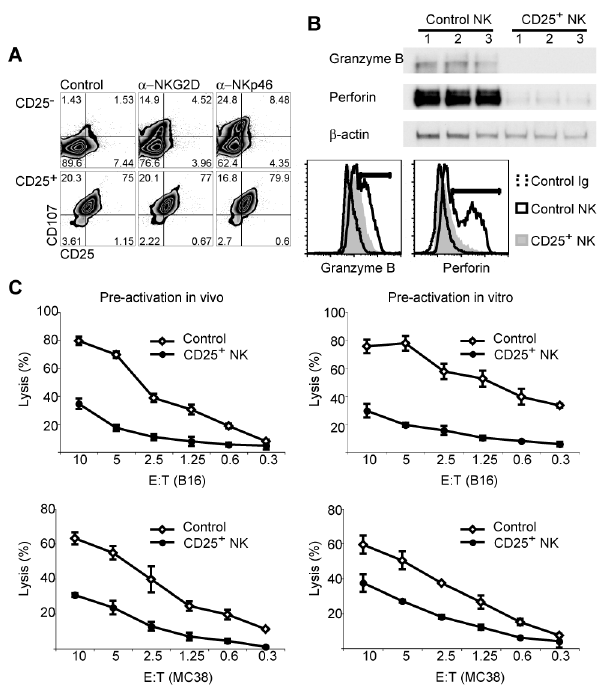
Figure 2. Post-activation NK cells have reduced cytolytic activity. A. Post-activation CD25 + and non-activated CD25 2 NK cells were isolated from spleens of B16-bearing mice and were incubated immediately with activating antibodies against NKG2D or NKp46 in the presence of anti-CD107 antibody to detect degranulation. While the degranulation had to be induced in CD25 2 NK cells by the activating antibodies (top row), CD25 + NK cells degranulated spontaneously. B. Post-activation CD25 + NK cells isolated from spleens of B16-bearing mice and control NK cells isolated from normal spleens were expanded for 7 days in IL-2 in vitro. Western analyses (top) using three independent isolations each revealed reduced protein levels of granzyme B and perforin but similar levels of b -actin in post-activation NK cells. Intracellular cytometry analyses (bottom) of NK1.1 + cells showed that only control but not post-activation NK cells contained populations with high levels of granzyme B and perforin. C. NK cells that had been activated in vivo in B16-bearing mice (left) or in vitro (right) and control NK cells were sorted and expanded in IL-2. Lysis assays revealed reduced cytotoxicity of post-activation NK cells both towards B16 (upper) and towards MC38 cells (lower) when compared to control NK cells. Data are shown + / 2 SD. Analyses were done in at least three independent experiments giving similar results.